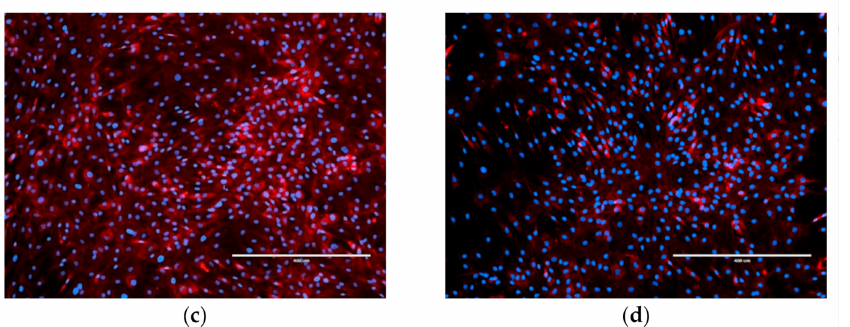
Figure 2. The immunocytochemical characterisation of cartilaginous endplate cells in the first passage. ( a ) The cell morphology was characterised using an orange fluorescent phalloidin conjugate that selectively binds to actin filaments (red). In low-density cultures, the cells show round to polygonal shape with actin filaments in the cytoplasm. ( b ) The cells positive for aggrecan are green. ( c ) The presence of collagen II and ( d ) collagen I is demonstrated in red colour. Nuclei were counter-stained with DAPI (blue). Images were taken at 10 × magnification on an EVOS FL fluorescence microscope. Scale bar = 400 µ m. Negative and positive controls are shown in the Supplementary Materials (Figures S1 and S2).